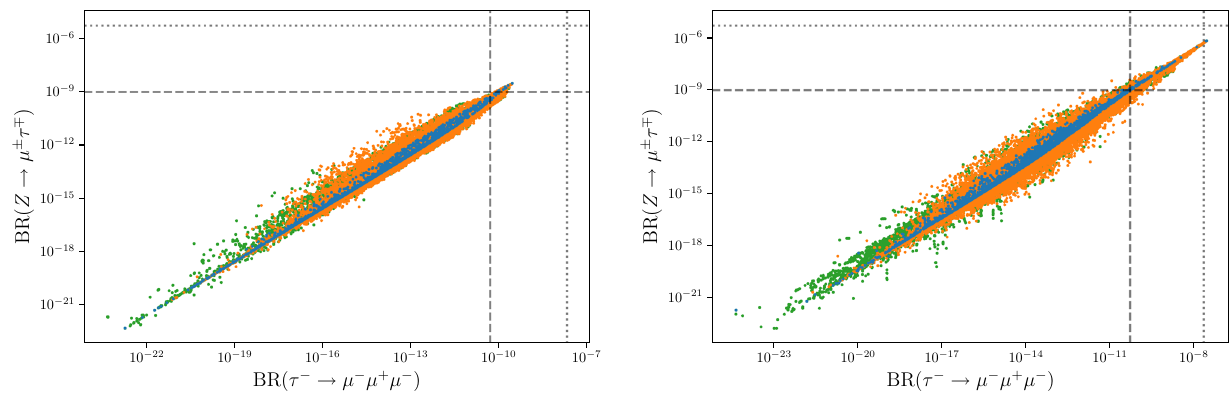
Fig. 14 Correlation of Z → μτ and τ → 3 μ decays, for varying values of the CPV Dirac and Majorana phases. Line and colour code as in Fig. 12. On the left panels, m 4 = m 5 = 1TeV, while on the right we set m 4 = m 5 = 5TeV